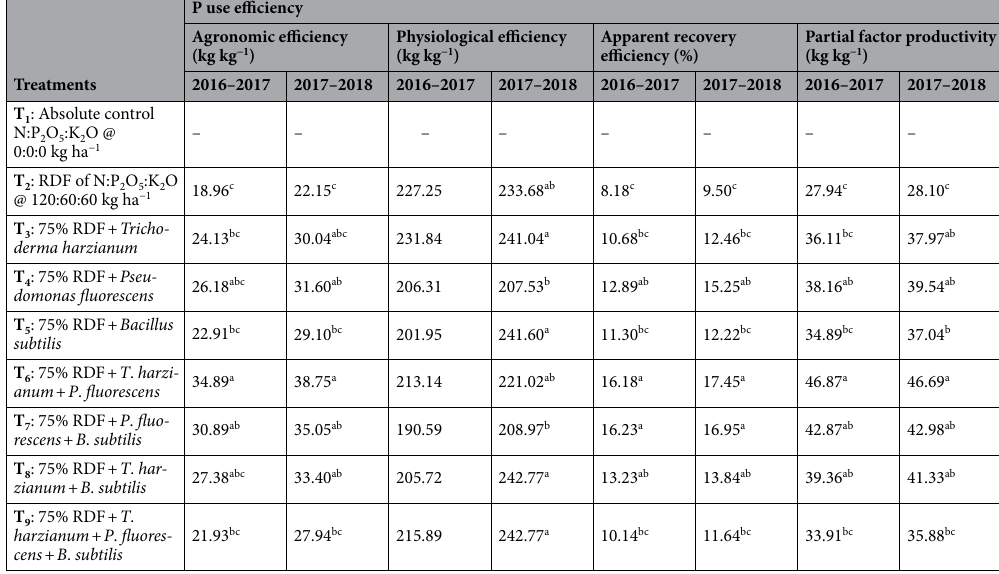
Table 2. Phosphorus use efficiency of red cabbage as influenced by bio-priming and fertilisation. Different letters indicate significant differences at P ≤ 0.05 among the treatments as per